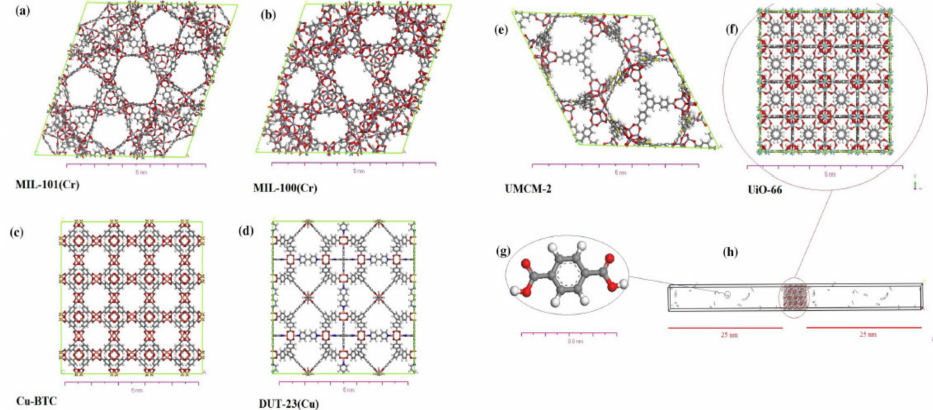
Figure 5. ( a ) MIL-101(Cr), ( b ) MIL-100(Cr), ( c ) Cu-BTC, ( d ) DUT-23(Cu), ( e ) UMCM-2, ( f ) UIO-66, ( g ) TPA molecule, and ( h ) simulation box (Ref.